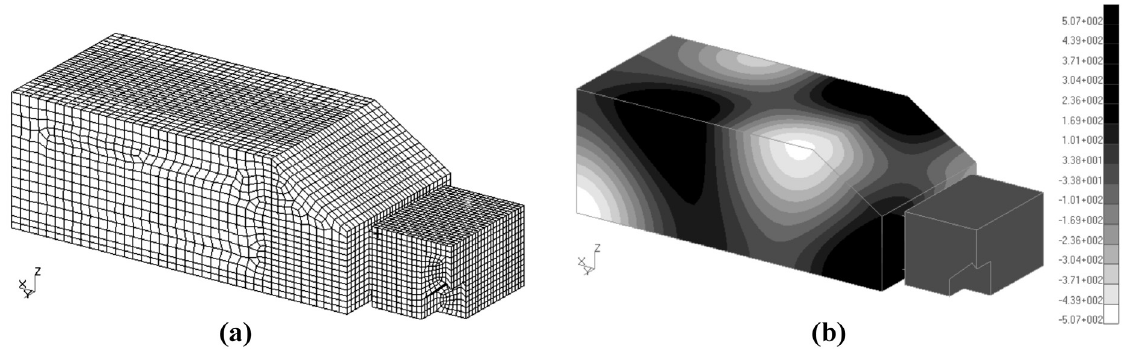
Fig. 4. Mock-up cavities: (a) FE mesh and (b) uncoupled mode at 192.5